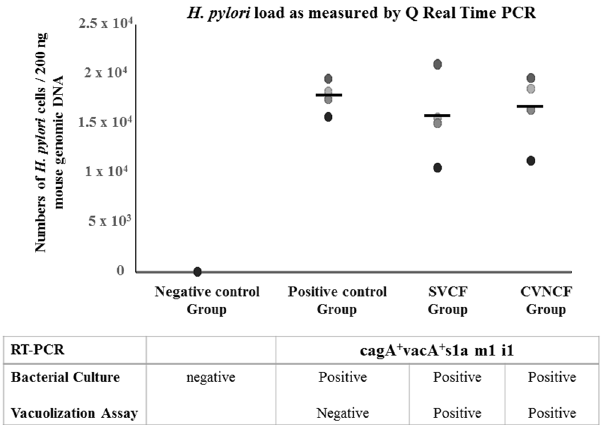
Figure 6. Load of Helicobacter pylori in gastric mucosa of the experimentally infected groups of balb c/mice as measured by quantitative real-time polymerase chain reaction (qPCR). Four groups of mice were fed orally uninfected UHT milk ( Negative control Group ) or UHT milk containing SS1 reference strain ( Positive control Group ), spiral viable culturable form ( SVCF Group ) or coccoid viable non-culturable form of H . pylori ( CVNCF Group ). Each dot represents an individual mouse, the middle horizontal lines indicate mean values. Bacterial load was measured in the gastric mucosa using qPCR and the results are shown as number of bacterial cells per 200 ng of mouse genomic DNA. Homogenates of the gastric mucosa were also examined for mRNA expression of H . pylori virulence genes using RT-PCR and were further subjected to bacterial